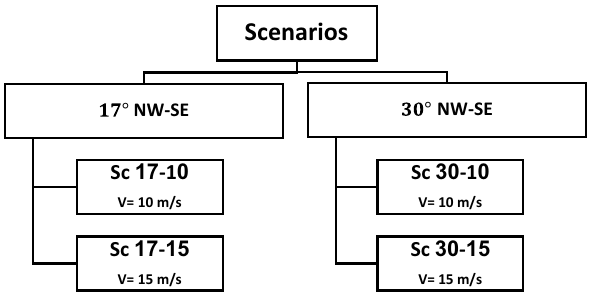
Figure 7. Scenarios for CFD of wind-driven ventilation.